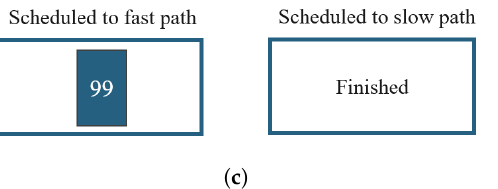
Figure 1. Optimal scheduling method. ( a ) Time 1. ( b ) Time n − 1. ( c ) Time n.